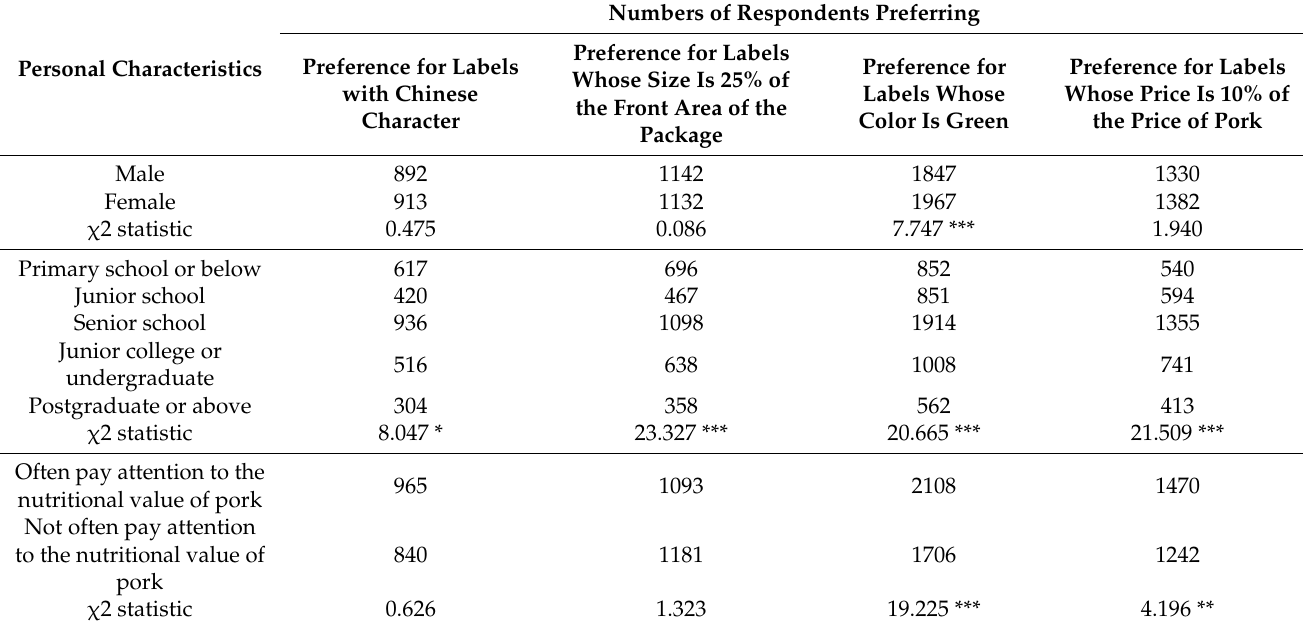
Table 7. Preference for labels’ attributes by consumers with different characteristics (categorical